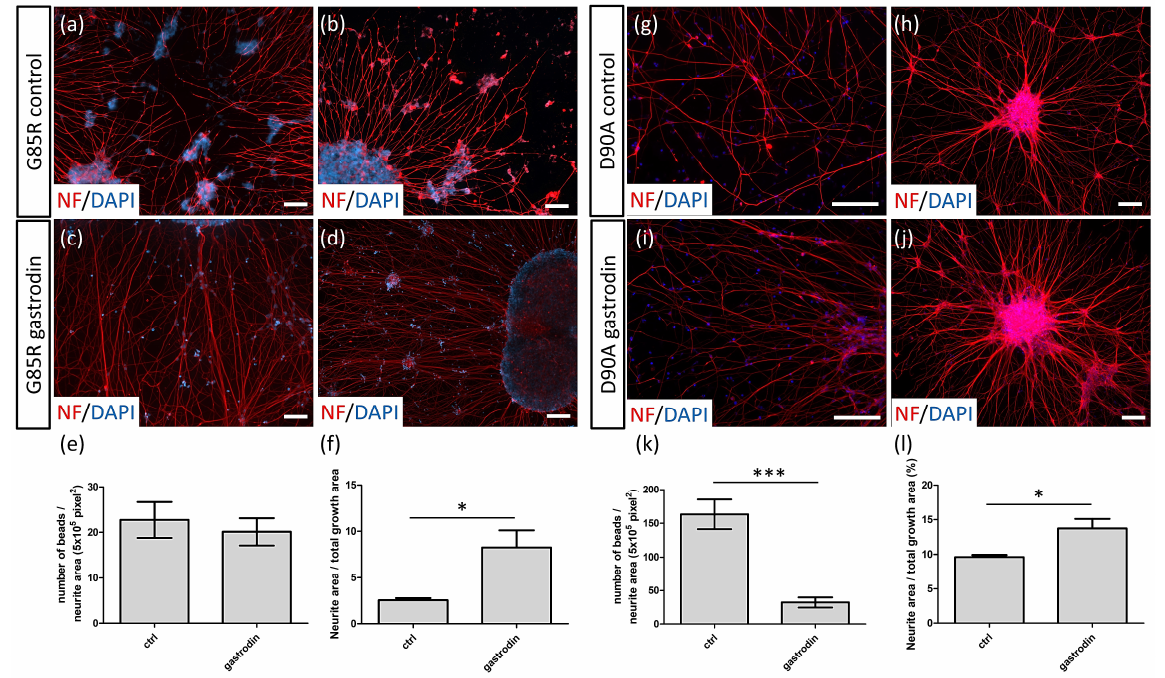
Figure 4. Gastrodin reduces nerve fiber abnormalities of SOD1 ALS MNs. ( a – d ) Nerve fiber beads ( a ) and neurite density ( b ) of untreated and gastrodin-treated SOD1 G85R (nerve fiber beads: c; neurite density: d) MNs identified with NF immunocytochemistry staining. ( e ) Number of nerve fiber beads of untreated (ctrl) and gastrodin-treated SOD1 G85R MNs at day 35 of differentiation. ( f ) Neurite density of untreated (ctrl) and gastrodin-treated SOD1 G85R MNs at day 28 of differentiation. ( g – j ) Nerve fiber beads ( g ) and neurite density ( h ) of untreated and gastrodin-treated SOD1 D90A (nerve fiber beads: ( i ); neurite density: ( j )) MNs. ( k ) Number of nerve fiber beads of untreated (ctrl) and gastrodin-treated SOD1 D90A MNs at day 35 of differentiation. ( l ) Neurite density of untreated (ctrl) and gastrodin-treated SOD1 D90A MNs at day 28 of differentiation. * p < 0.05, and *** p < 0.001. Scale bar, 100 µ